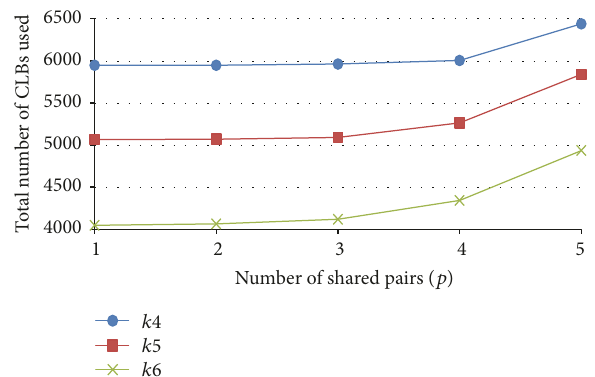
Figure 5: Comparison of the clustering methods for 𝑁 = 10 .